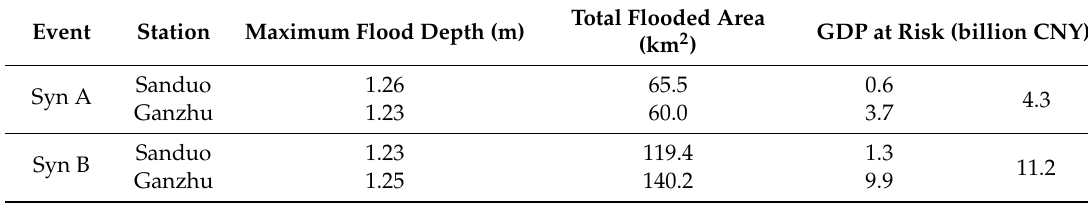
Table 5. Summary of the GDP exposure at risk for the two synthetic